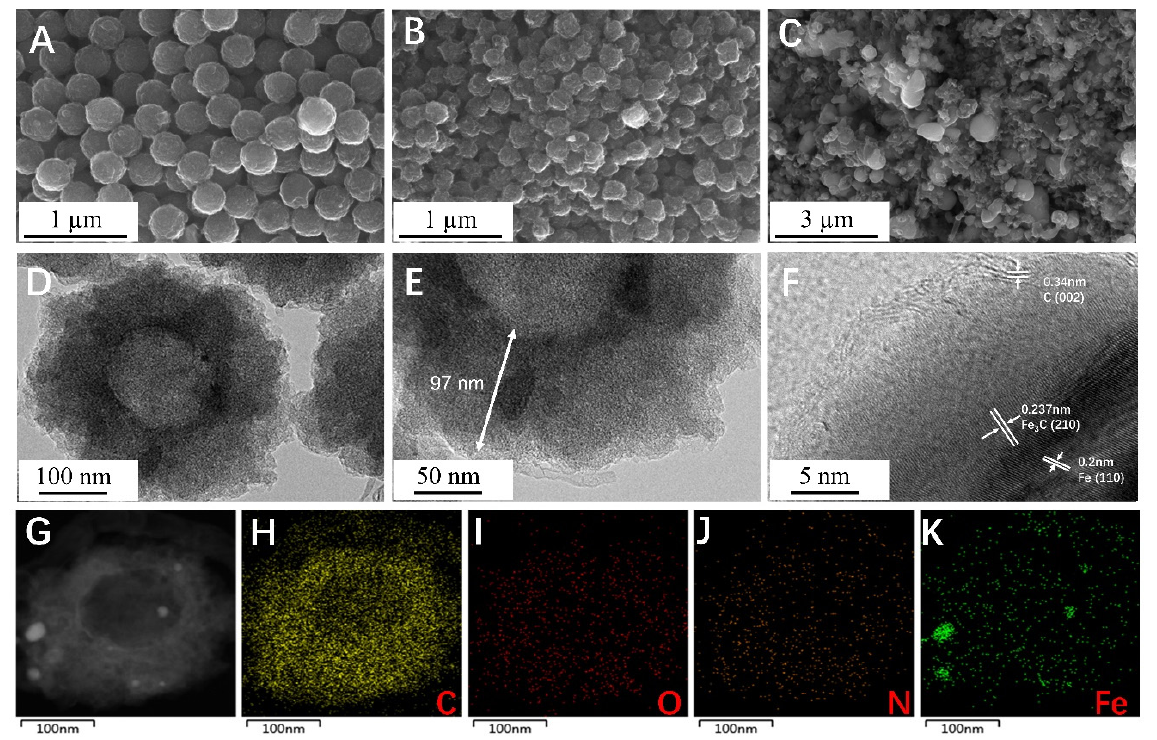
Figure 1. SEM images of Fe − NC − 700 ( A ), Fe − NC − 800 ( B ), Fe − NC − 900 ( C ); TEM images of Fe − NC − 800 ( D – F ), the arrow in Figure 1E represents the thickness of the graphite carbon layer of ( D – F ), the arrow in ( E ) represents the thickness of the graphite carbon layer of the carbon sphere; the carbon sphere; EDS mapping images of Fe − NC − 800 ( G – K ). EDS mapping images of Fe–NC–800 ( G – K ).